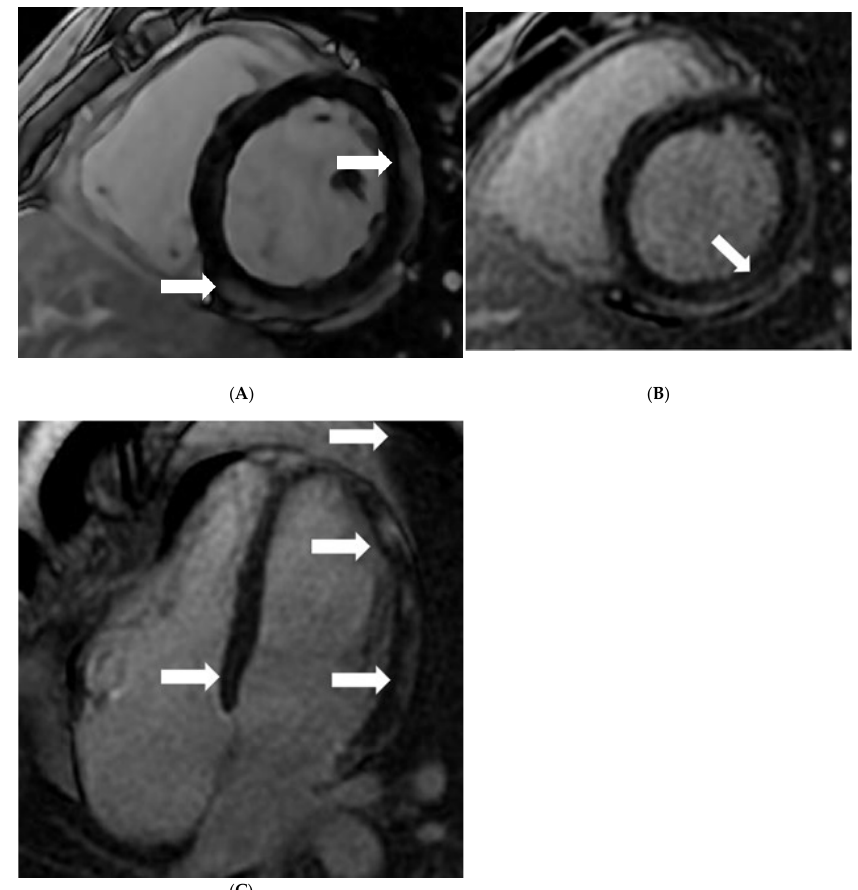
Figure 1. CMR imaging demonstrates epicardial type of late gadolinium enhancement involving the mid-inferoseptal and mid-anterolateral segments (Arrow) ( A ), the midwall type of LGE involving the basal-inferolateral segments (Arrow) ( B ), and multiple patchy type LGE involving the antero-lateral, lateral, with inferior septal midwall (Arrow) ( C ).